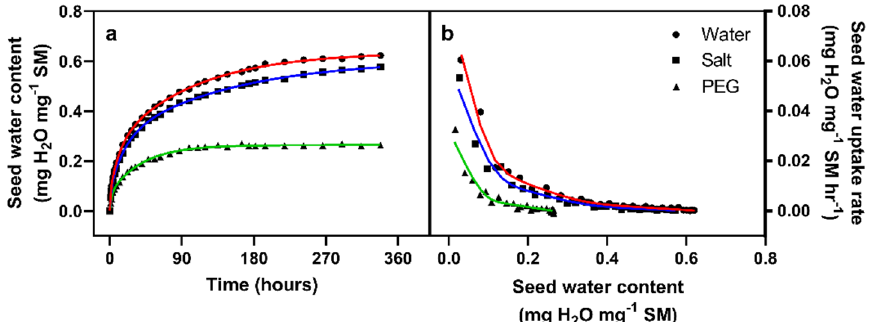
Figure 4. ( a ) Water uptake curves for seeds incubated in water (red curve), − 1 MPa NaCl (blue), or − 1 MPa PEG (green) solutions. ( b ) rate of seed water uptake plotted against seed water